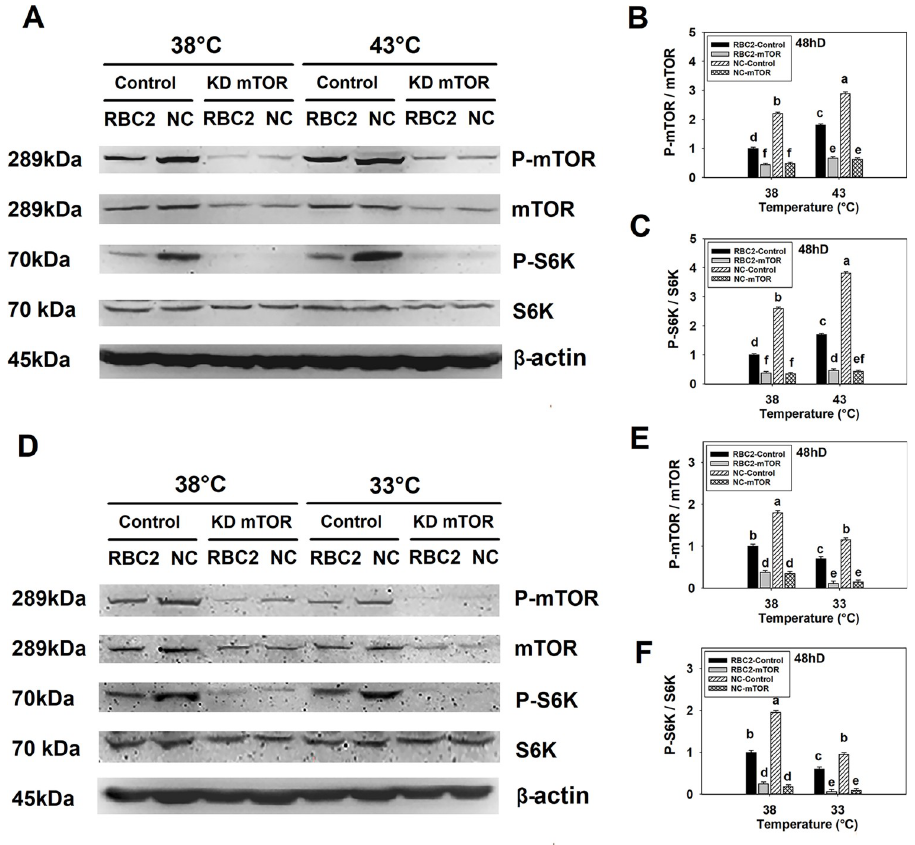
Fig 4. Effects of heat or cold thermal stress and siRNA-mediated mTOR knockdown at the beginning of proliferation on the phosphorylation of mTOR and S6K in RBC2 and NC line SCs. (A) Protein levels of the unphosphorylated and phosphorylated forms of mTOR and S6K, and an internal control β -actin in SCs from the RBC2 and NC lines cultured at 38˚ and 43˚C was determined by western blot analysis at 48 h of differentiation. (B) The densitometric ratio of phosphorylated to unphosphorylated mTOR as shown in (A) was analyzed in each treatment group. (C) The densitometric ratio of phosphorylated to unphosphorylated S6K as shown in (A) was analyzed in each treatment group. (D) Protein expression of the unphosphorylated and phosphorylated forms of mTOR and S6K, and the protein expression of an internal control β -actin in SCs from the RBC2 and NC lines cultured at 38˚ and 33˚C was determined by western blot analysis at 48 of differentiation. (E) The densitometric ratio of phosphorylated to unphosphorylated mTOR as shown in (D) was analyzed in each treatment group. (F) The densitometric ratio of phosphorylated to unphosphorylated S6K as shown in (D) was analyzed in each treatment group. Each treatment is shown above each lane in (A) and (D), “Control” group represents cells were transfected with a negative control siRNA, and “KD mTOR” group represents cells were transfected with an mTOR targeting siRNA. Molecular weight and name of each target protein is shown on the left and right side of each figure, respectively in (A) and (D). Each graph bar represents a mean ratio, and each error bar represents a standard error of the mean value. Mean values with different letters are significantly different ( P � 0.05). observed in the RBC2 and NC lines compared to the control groups at 33˚C (Fig 4D and 4E). There was a significant interaction effect among the effects of temperature, line, and knock- down of mTOR at 48 h of differentiation ( P < 0.0001, Fig 4D and 4E). At 48 h of differentiation, phosphorylation of S6K was also lower in the RBC2 and NC mTOR knockdown groups compared to the control groups at 38˚ and 33˚C ( P < 0.0001, Fig 4D and 4F). At 33˚C, phosphorylation of S6K was decreased 8.57-fold ( P < 0.0001) and 10.59-fold ( P < 0.0001) in the RBC2 and NC mTOR knockdown groups compared to the con- trols (Fig 4D and 4F). There was significant interaction ( P < 0.0001) among the effects of tem- perature, line, and knockdown of mTOR at 48 h of differentiation (Fig 4D and 4F).